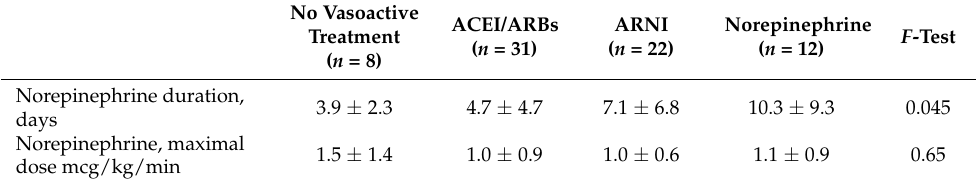
Table 2. Post-operative use of norepinephrine.